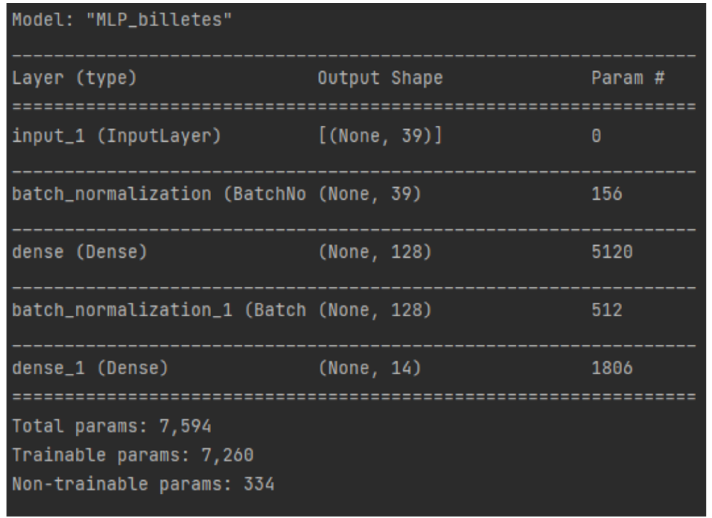
Figure 22. Summary of the implemented MLP.